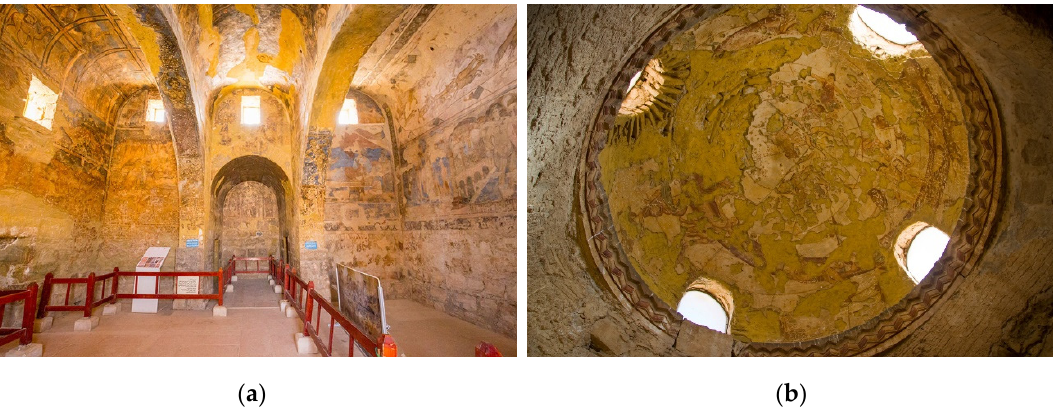
Figure 3. Internal view of the walls of Qaser Amra: ( a ) Entrance to the bath area—apodyterium; ( b ) Zodiac painting on a caldarium dome. (Ref. Department of Antiquities of